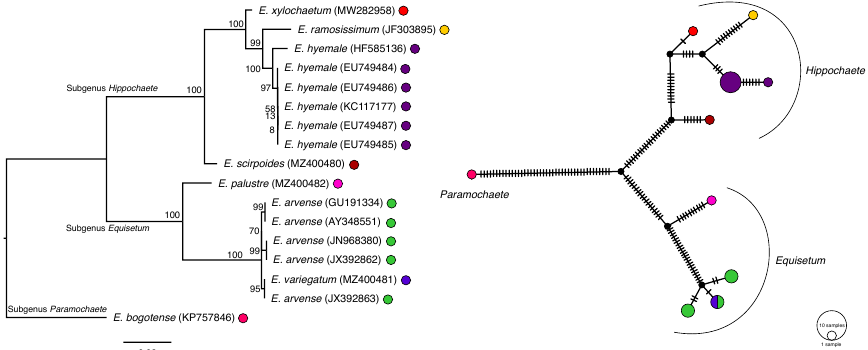
Figure 4. Phylogenetic estimation and TCS network of Equisetum matK sequences. The scale bar of the tree represents the estimated number of nucleotide substitutions per site. The maximum- likelihood bootstrap values are reported at the respective nodes. The colours of taxa present in the tree correspond with the colours in the TCS haplotype map. The size of the circle represents the number of the taxa that share the same haplotype.